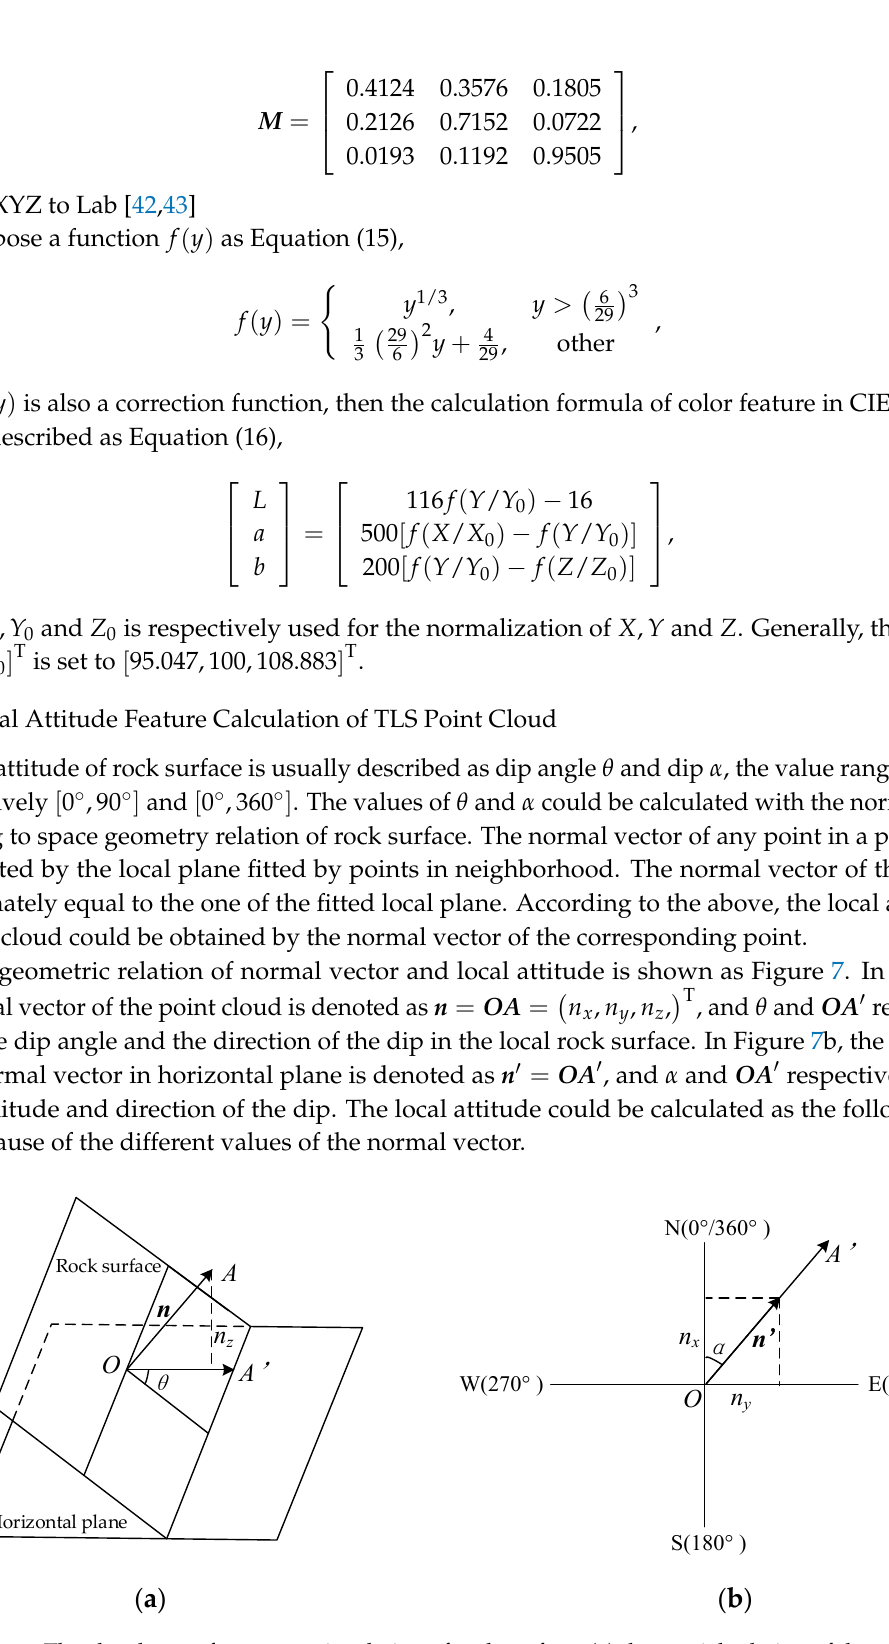
Figure 7. The sketch map for geometric relation of rock surface: ( a ) the spatial relation of the normal vector and the local attitude; ( b ) the geometric relation of the normal vector and the local dip in projection plane.